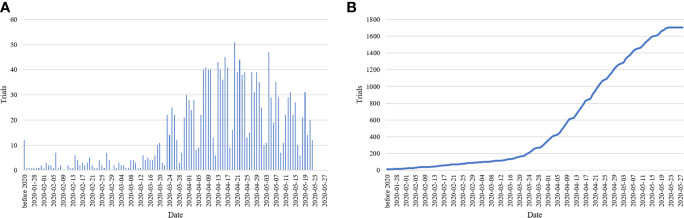
Bar chart of registered studies per day (A) and cumulative sum chart of registered studies (B).